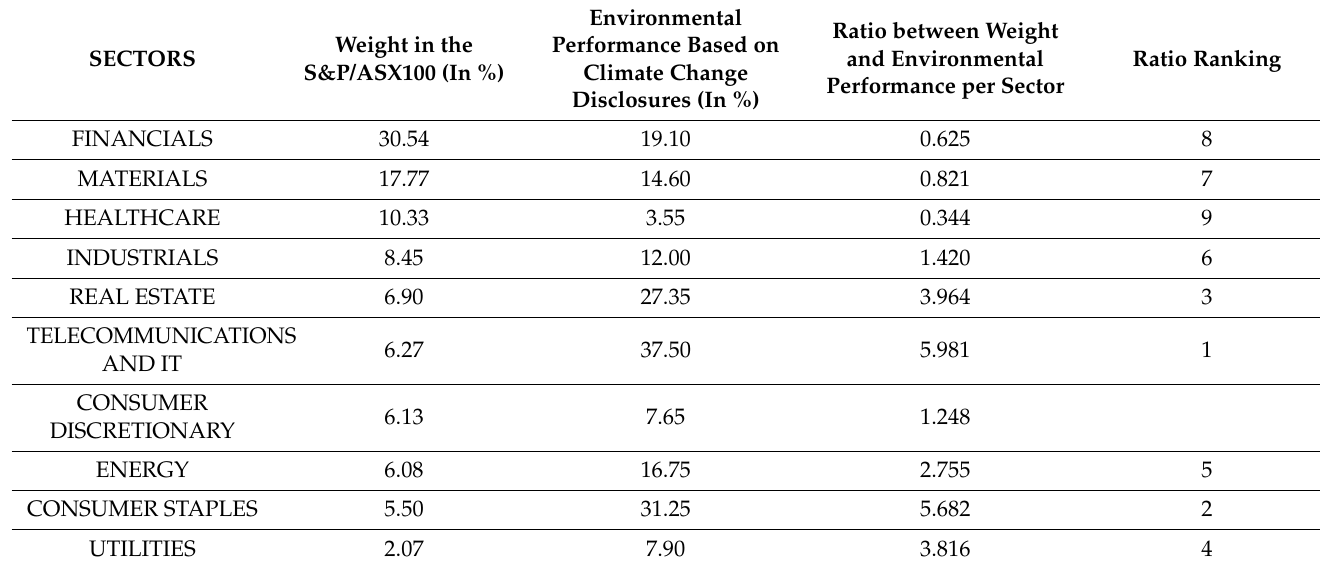
Table 2. Weight and environmental performance ratio and ranking in ASX100